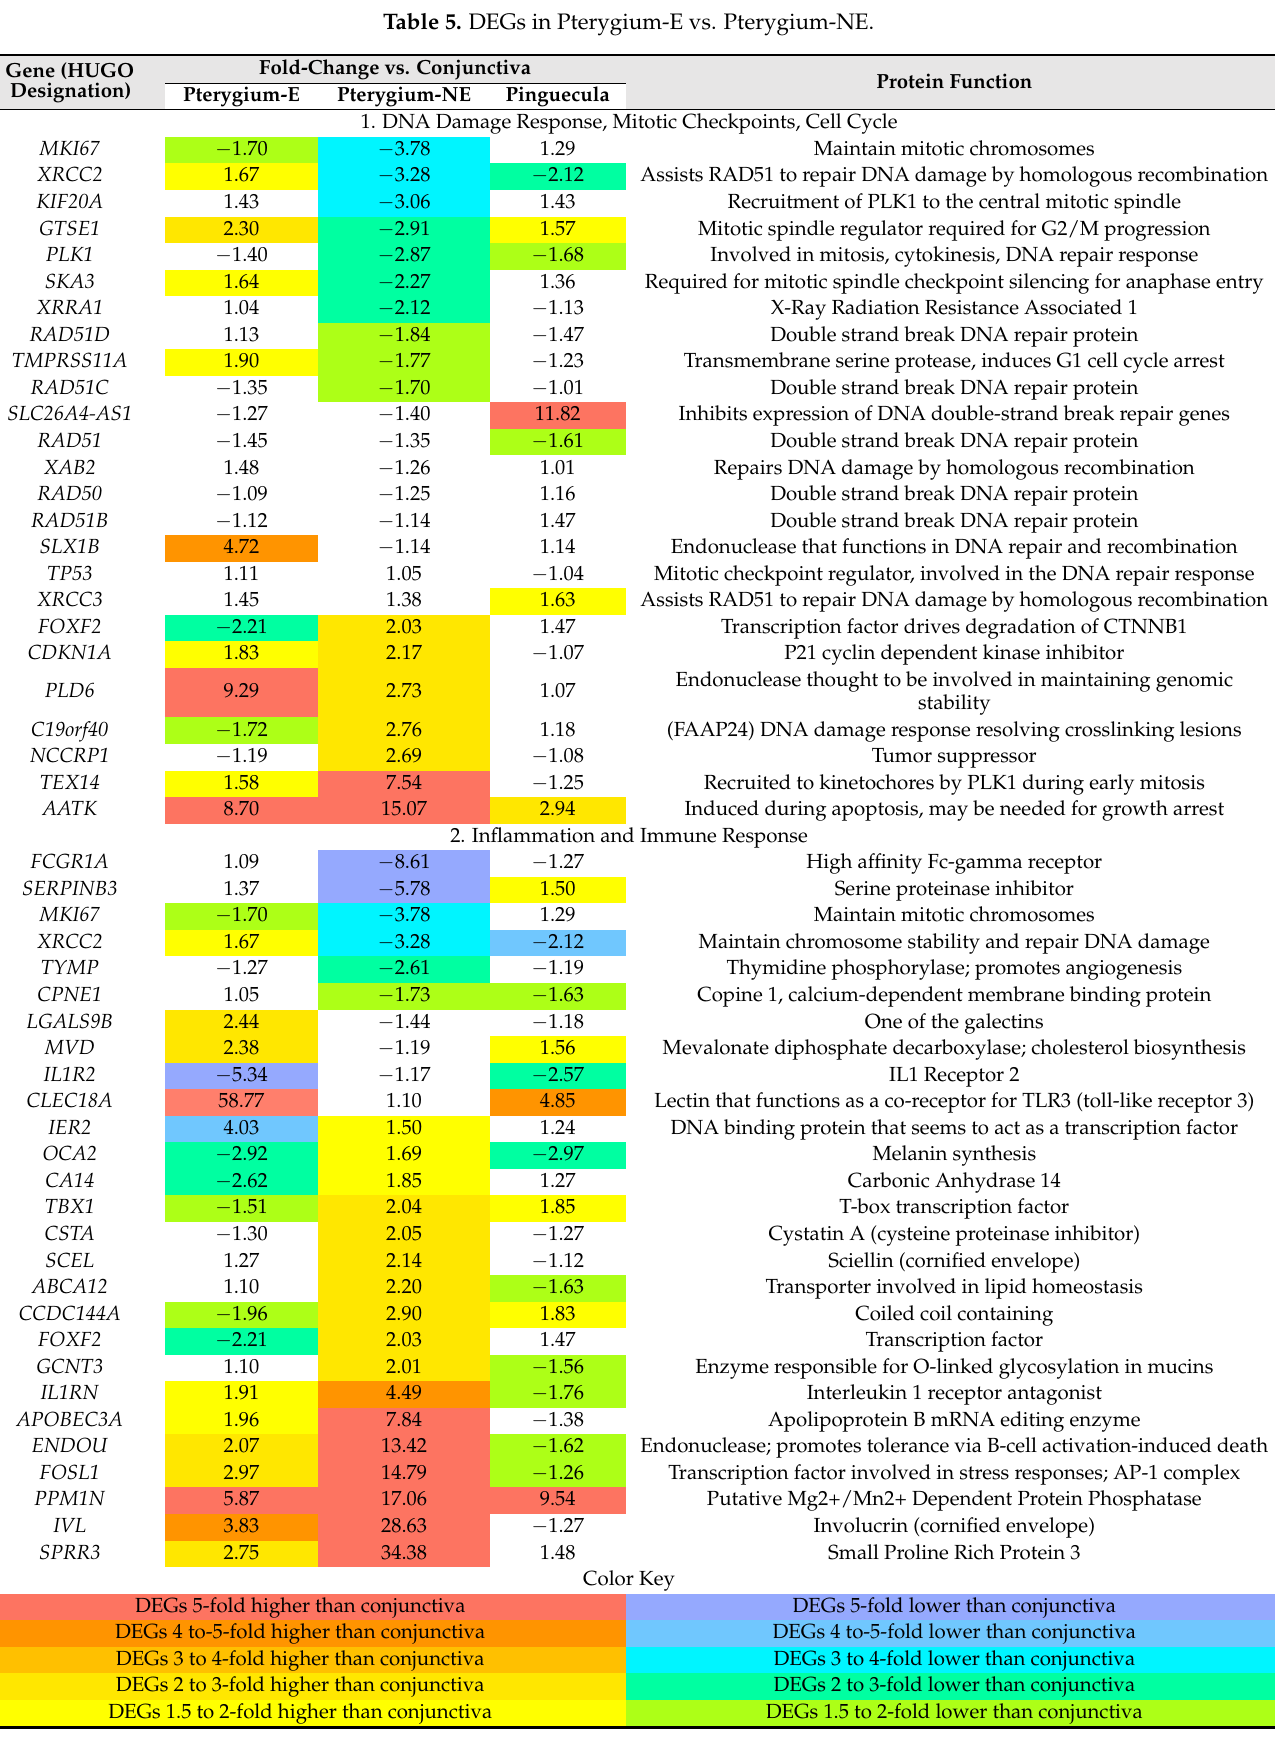
Table 5. DEGs in Pterygium-E vs.